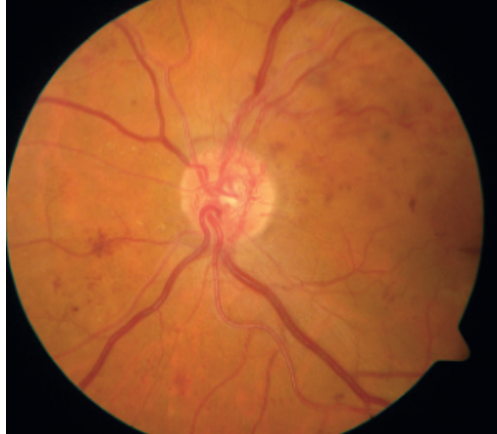
Figure 4. Proliferative Diabetic Retinopathy.